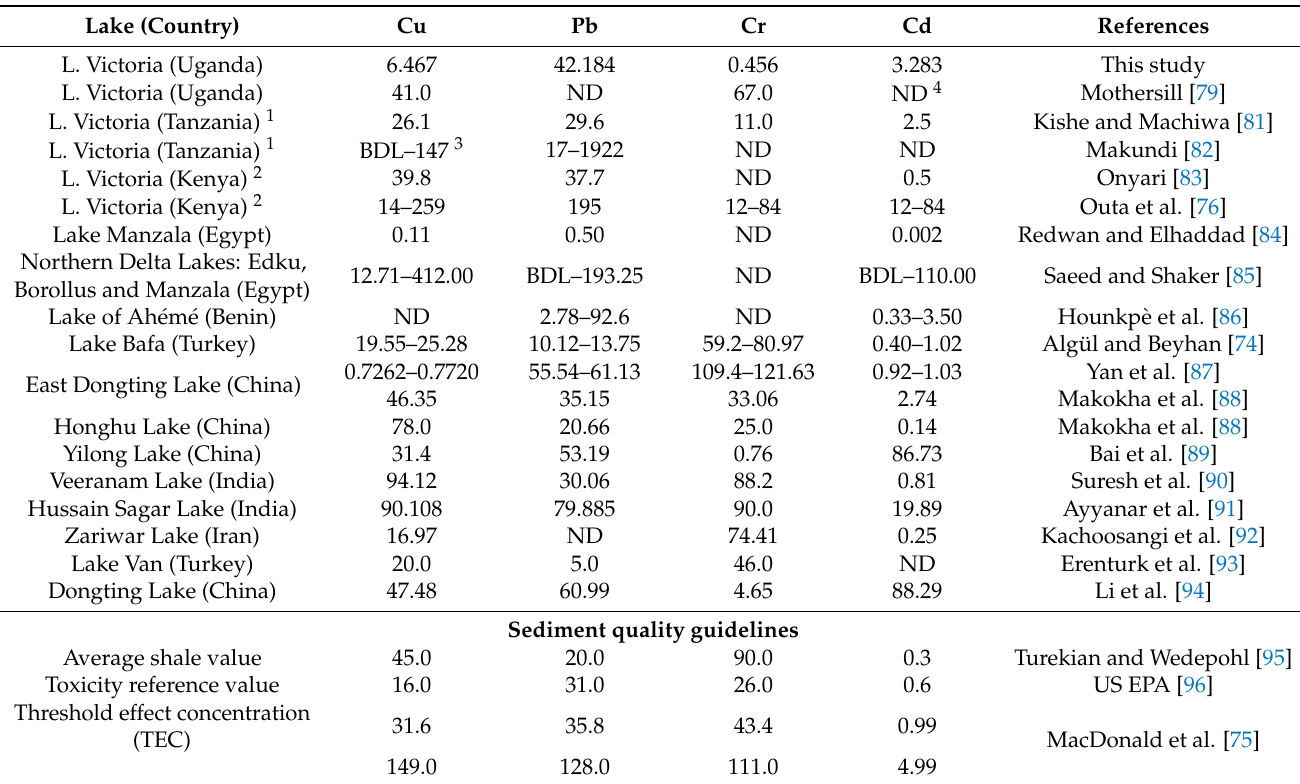
Table 2. Comparison of trace metals in sediments (mg/kg) from Port Bell, L. Victoria, Uganda with international sediment guidelines, previous and other global reports.